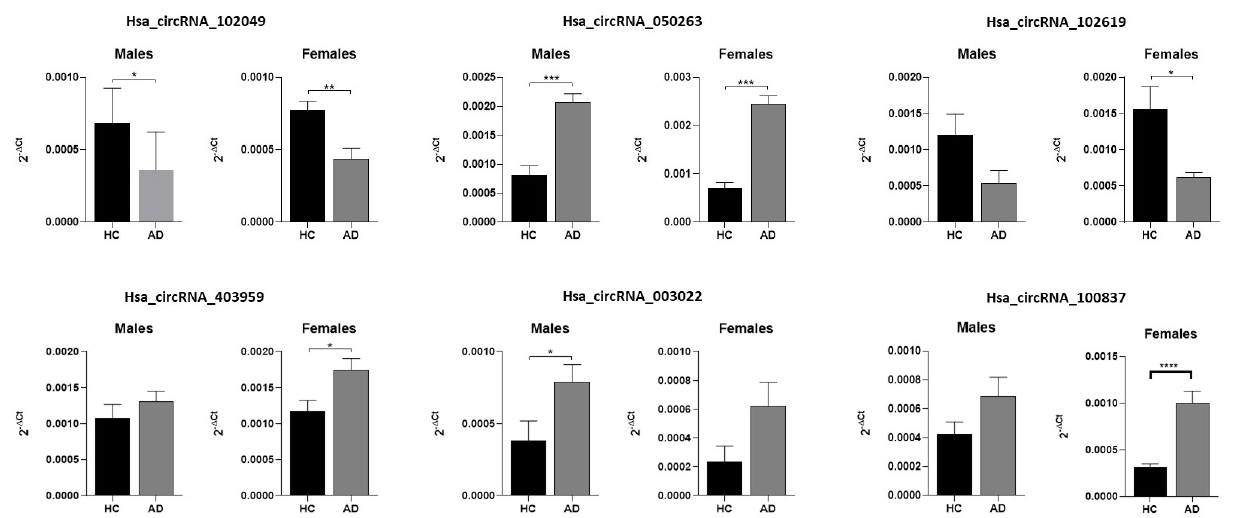
Figure 2. Graphic representation of circRNA expression levels in males and females in subjects with